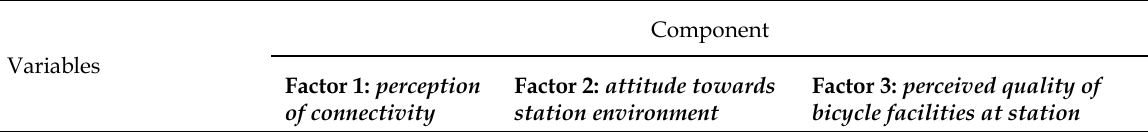
Table 2. Factor loadings, with significant variables in